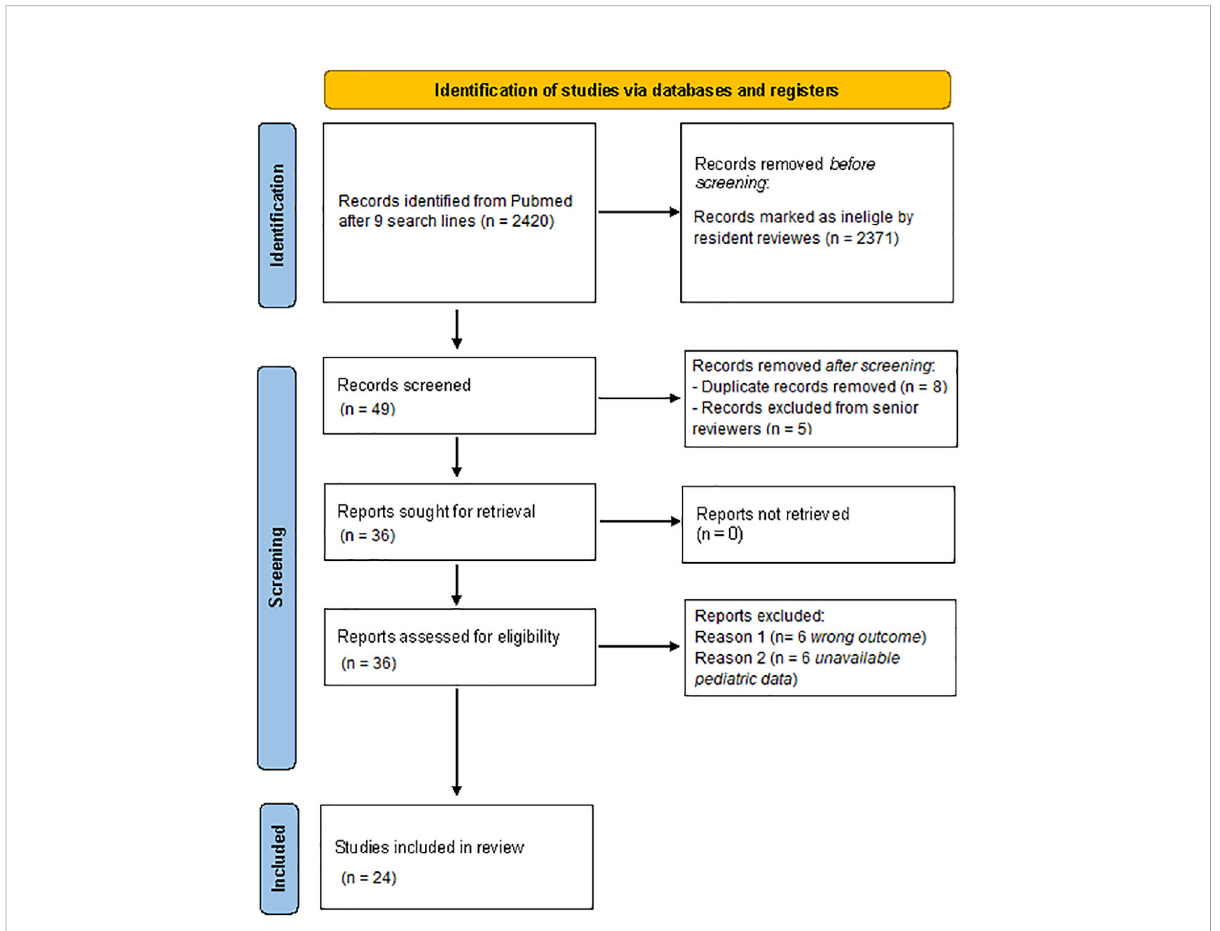
FIGURE 1 Flowchart of the study selection according to the PRISMA guidelines. Performed following “ Page MJ, McKenzie JE, Bossuyt PM, Boutron I, Hoffmann TC, Mulrow CD, et al. The PRISMA 2020 statement: an updated guideline for reporting systematic reviews. BMJ 2021;372:n71. Doi: 10.1136/bmj.n71 ”